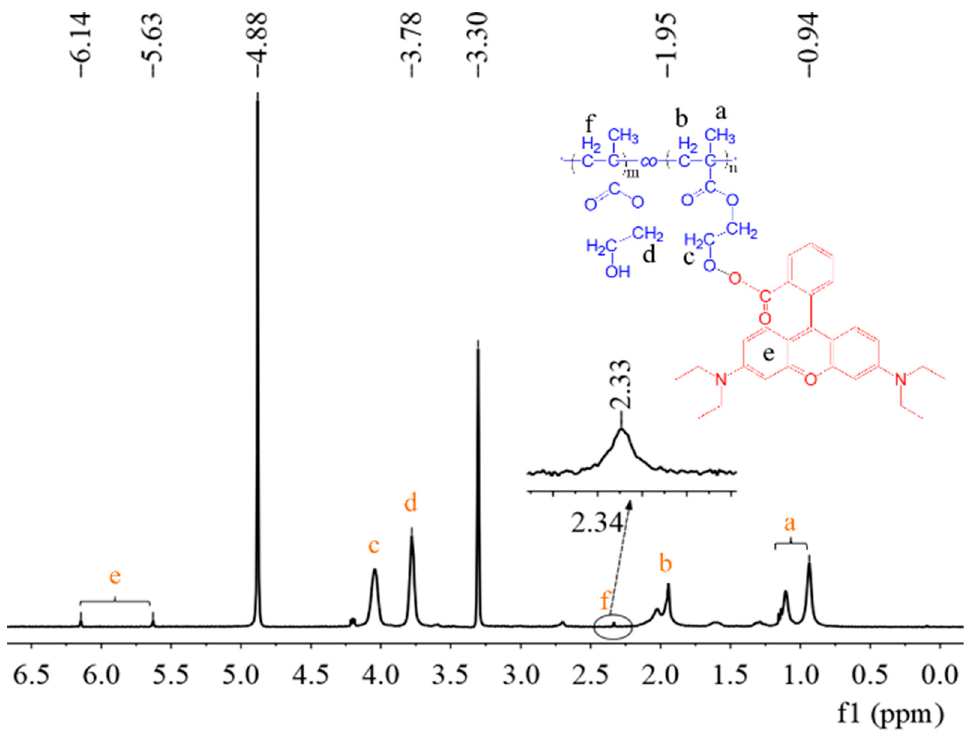
Figure 5. 1 H NMR spectrum of PHEMA- co -PHEMA-RhB formed in solution.